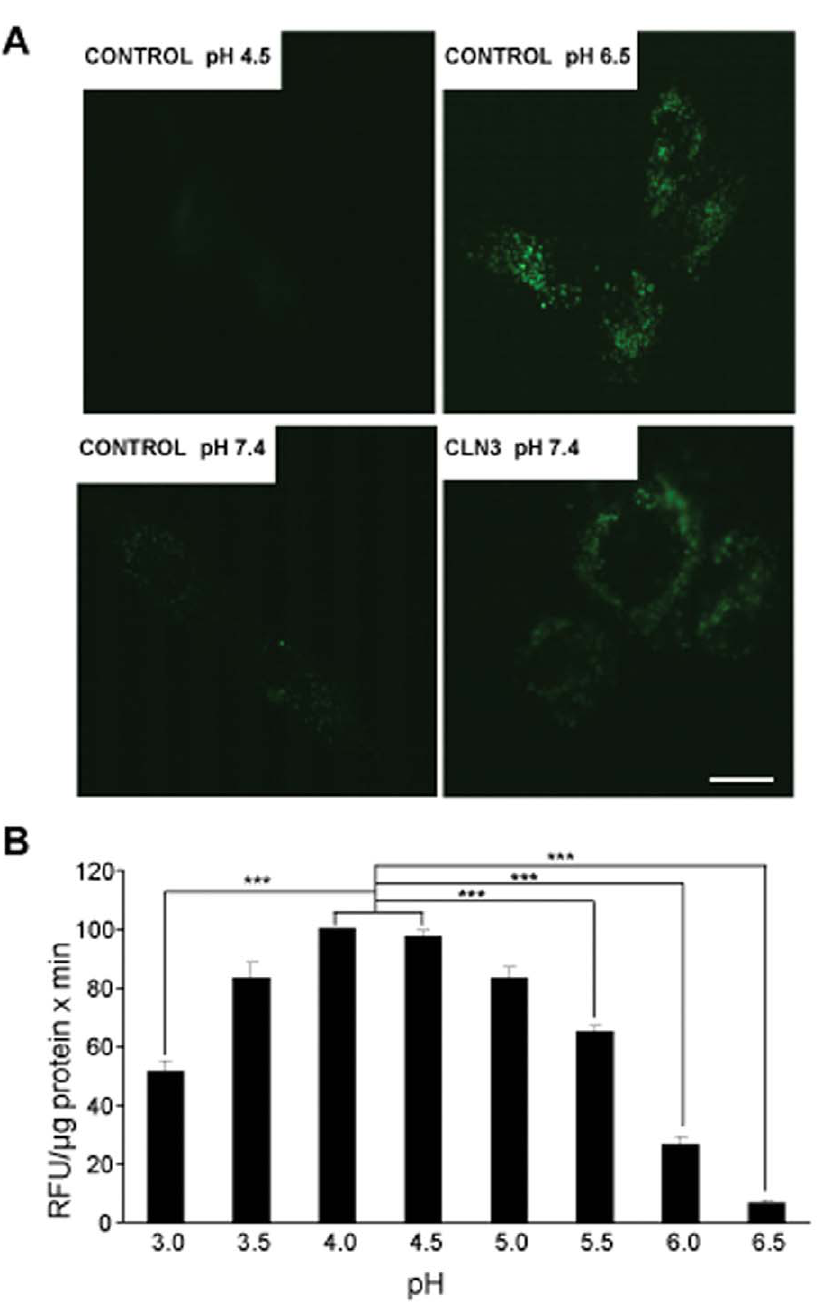
Figure 6. Lysosomes in CLN3 fibroblasts have a higher pH. (A) Exponentially growing control, CLN2 and CLN3 fibroblasts were treated as described in Materials and Methods. Cells were observed by fluorescence microscopy using an inverted microscope and over 200 images were randomly taken at each pH. Upper and lower images show representative photographs of, respectively, permeabilized control fibroblasts incubated in media at pHs 4.5 (left) and 6.5 (right), and non-permeabilized control (left) and CLN3 (right) fibroblasts incubated in high proteolysis medium (pH 7.4). Bar: 20 m m. (B) Effects of different pHs on TPP1 activity. Control fibroblasts were incubated under high proteolysis conditions and TPP1 activity was measured at different pHs using AAF-AMC. Measurements of AMC fluorescence and quantification of protein were carried out as described in Materials and Methods. Results are expressed as RFU values per minute and m g protein and are the mean and S.D. from three separate experiments with triplicated samples. Stars indicate statistically significant differences from pHs 4.0 and 4.5 (***p , 0.005). endocytosis. Two main differences we found between both NCL increase in lysosomal pH that affects autophagosome maturation forms that are relevant for macroautophagy. First, an activation of and, which correlates with the observed increase in LC3-II levels in the absence of lysosomal inhibitors. In addition, the reduced the Akt-mTOR pathway that affects autophagosome formation in CLN3, but mainly in CLN2 fibroblasts (where p38 a and ERK1/2 LC3-II levels in CLN2 and CLN3 fibroblasts treated with are also activated). Second, and only in CLN3 fibroblasts, an lysosomal protease inhibitors indicate impairment in autophago-